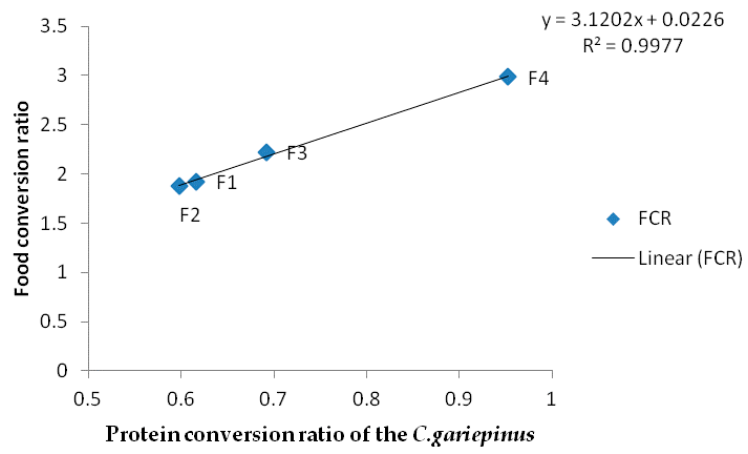
Figure 2. Relationship of protein conversion ratio and food conversion ratio (FCR) of African catfish C. gariepinus fed diets varying Chlorella vulgaris meal and fishmeal for 60 d.